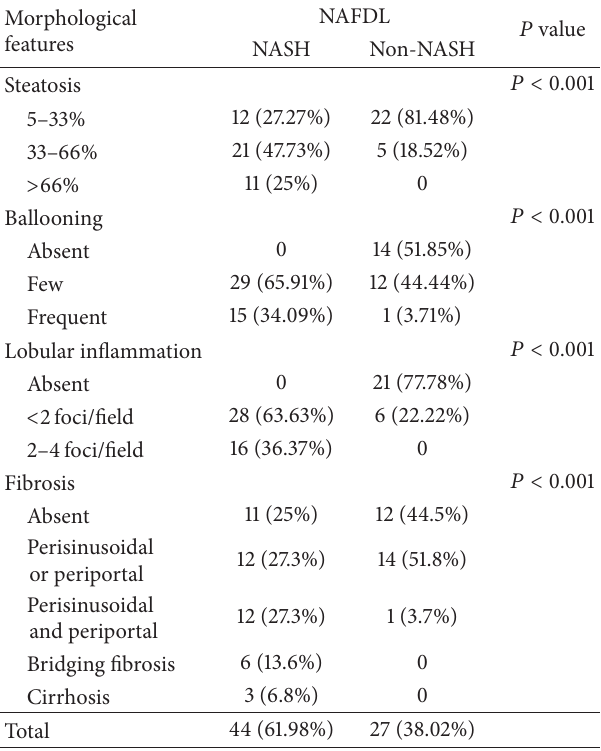
Table 1: Degree of morphological features and fibrosis stage in NASH and non-NASH biopsies according to Bedossa’s histological